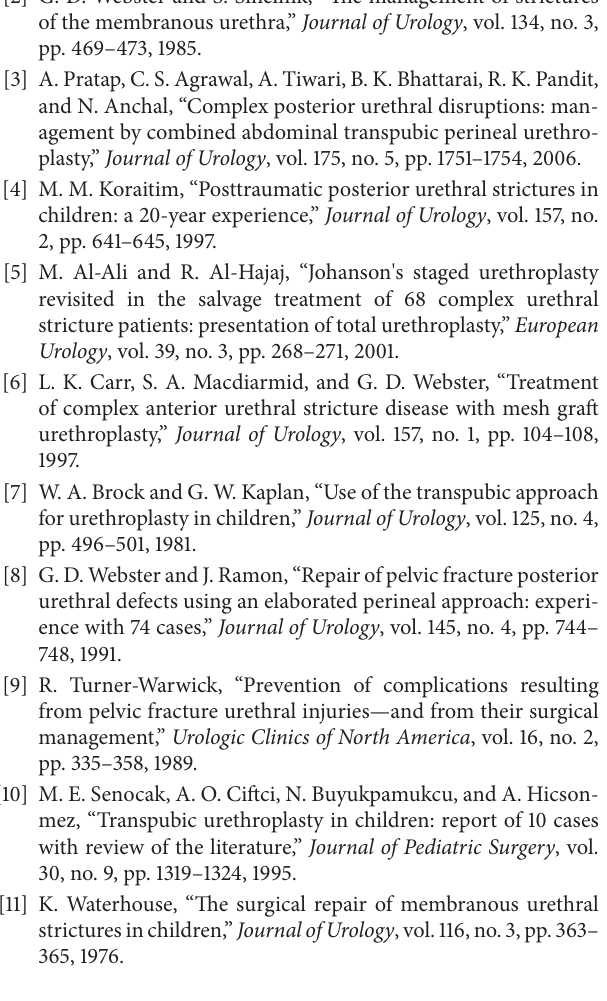
Table 2: Complication